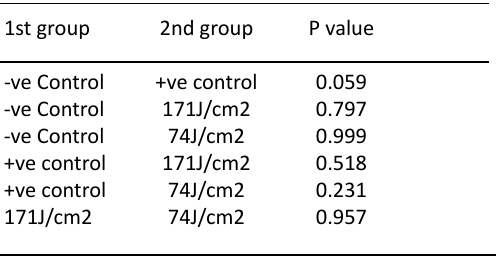
Table 15. Head circumferences comparison in day seven between every